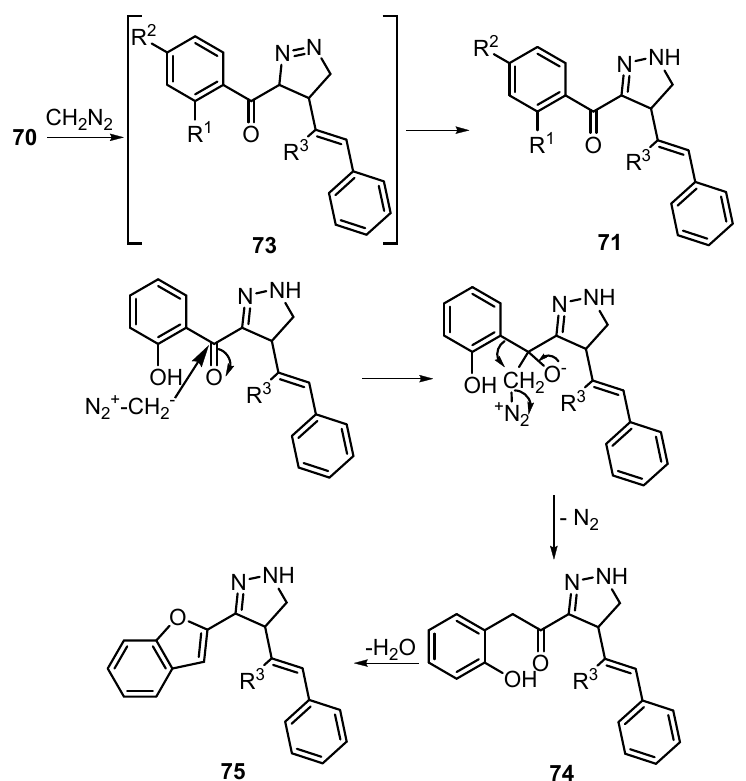
Scheme 22. Mechanism of formation of 3-benzoyl-4-styryl-2-pyrazolines 71 and 3-(2-benzofuranyl)-4-styryl-2-pyrazolines 75 [79].